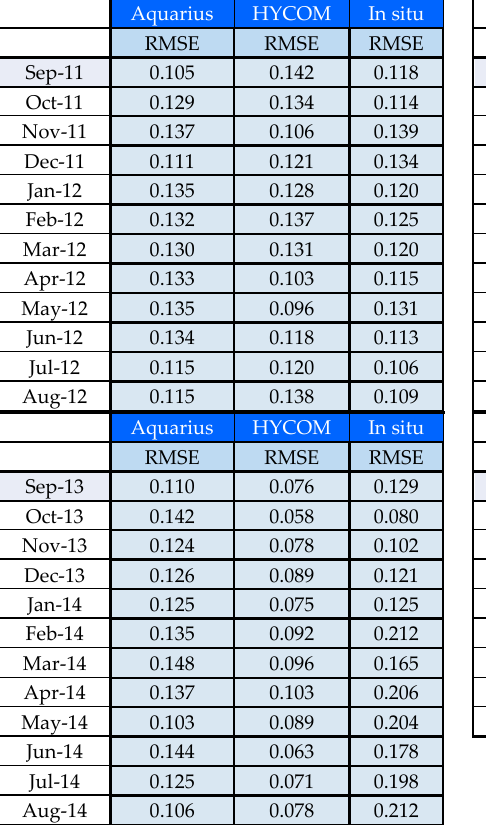
Table 2. Triple-point analysis: Monthly Root Mean Square Error (RMSE) differences for Aquarius, Hybrid Coordinate Ocean Model (HYCOM), and in situ fields. Each panel represents one year (September–August) beginning September 2011. At the bottom of the fourth panel, green highlight, are the average RMSE over the 45 months. Note that the Aquarius mean value is 0.128 psu.